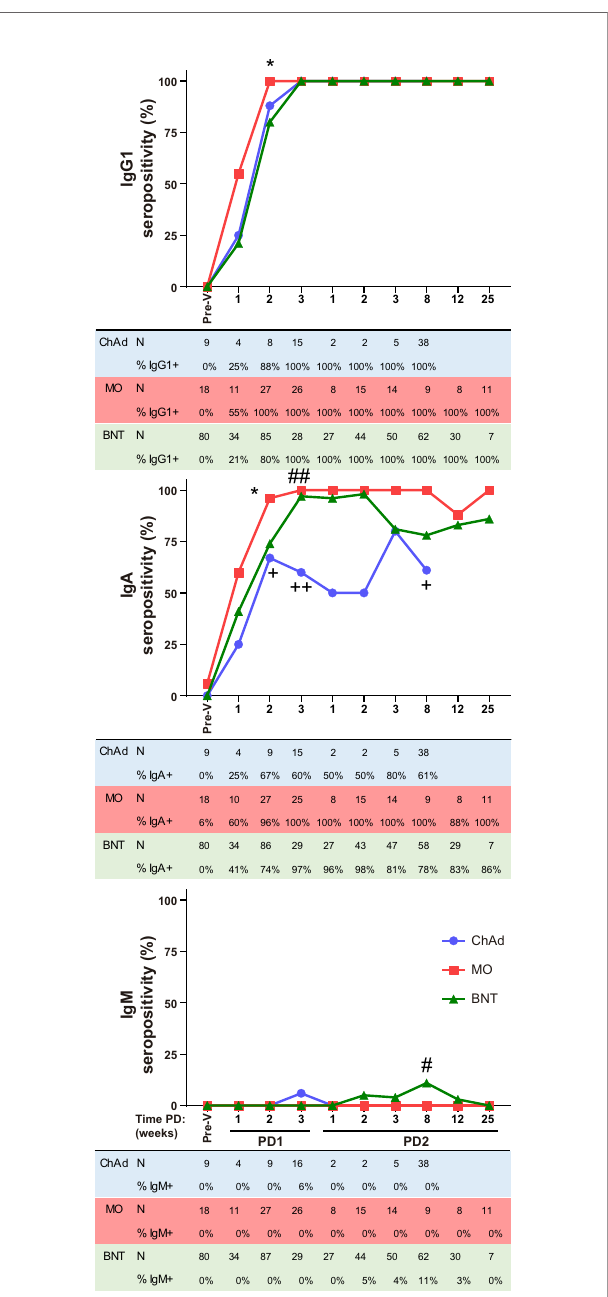
FIGURE 2 | Ig anti-Spike seropositivity follow-up after vaccination. IgG1, IgA and IgM seropositivity in ChAdOx1 (ChAd), mRNA-1273 (MO) and BNT162b2 (BNT) vaccinated donors evaluated with the JFCI pre-vaccination (Pre-V) and at different time periods after the fi rst (PD1) or the second (PD2) dose of the vaccines. Percentage of positive and total number of samples are depicted in tables below graphs. Samples were collected as 1 wk, 1-7 days; 2 wk, 8-16 days; 3 wk, 17-28 days; 8 wk, 29-60 days; 12 wk, 61-90 days; 25 wk, 91- 174 days. Statistic comparisons were carried out for matched time PD between vaccines: +, ChAd vs MO; #, ChAd vs BNT; *, MO vs BNT. P values were determined using two-tailed Fisher ’ s exact test. The number of symbols indicates the p value summary: no symbol, no signi fi cance; + , # , *, p<0.05; ++ , ## p ≤